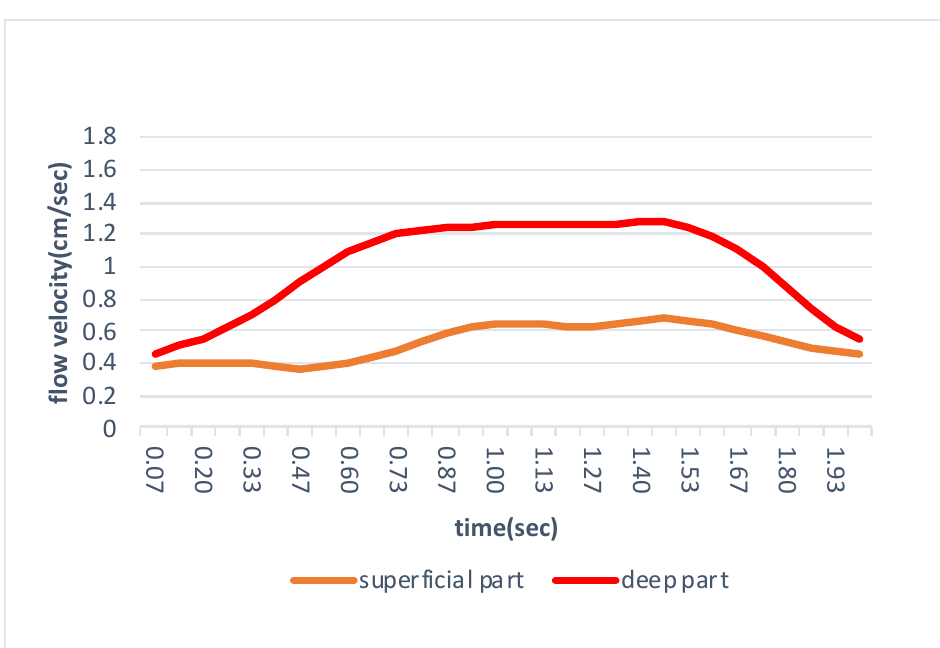
Figure 3. Time series data of the IFP superficial part and the IFP deep part.